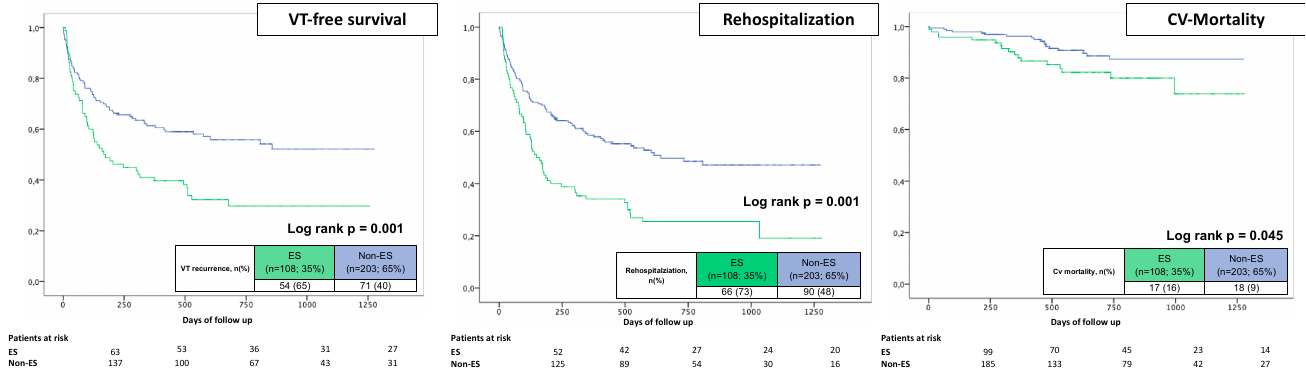
Figure 1. Multivariate logistic regression for the predictors of complete short-term success after catheter ablation of VT in ES and non-ES patients. CL, cycle length; LVEF, left ventricular ejection fraction; No. VT, number of VTs induced during the ablation; and VT CL, VT cycle length in milliseconds.